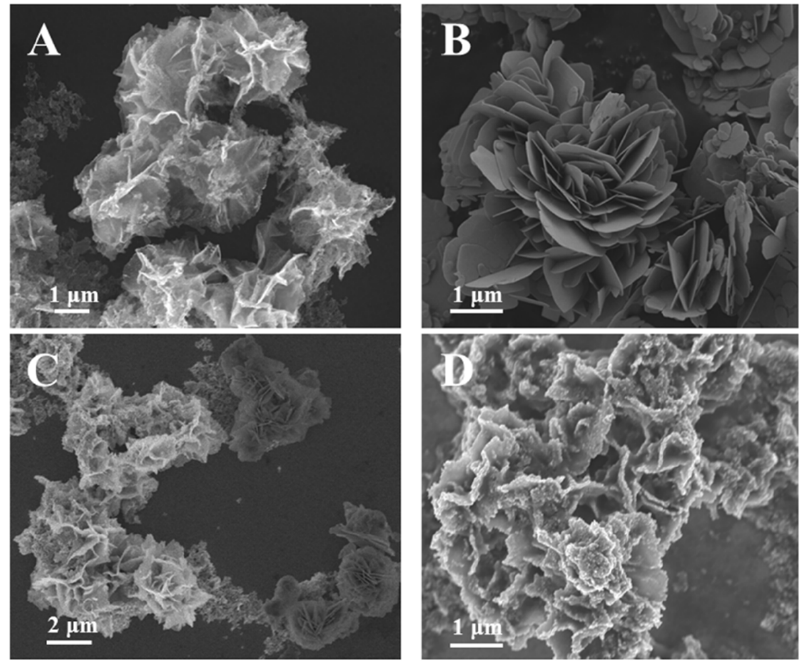
Figure 2. SEM images of SnO 2 ( A ), BiOI ( B ), SnO 2 /BiOI ( C ), SnO 2 /BiOI/Ag 2 S ( D ).